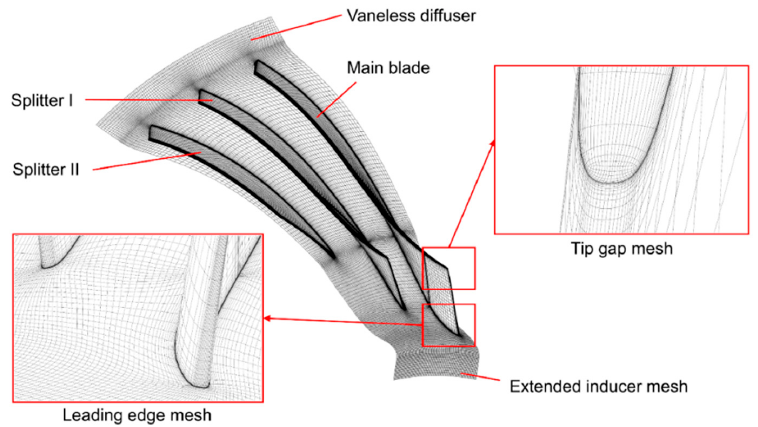
Figure 4. Created computational mesh in detail.